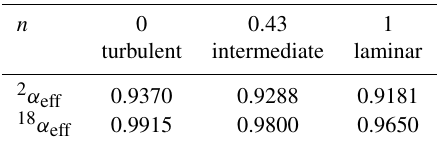
Table 2. Effective fractionation factors as a function of the flow pa- rameter n . For n = 0, the fractionation factors are equal to the equi- librium values at 35 ◦ C, as determined by Horita and Wesolowski (1994). n turbulent intermediate